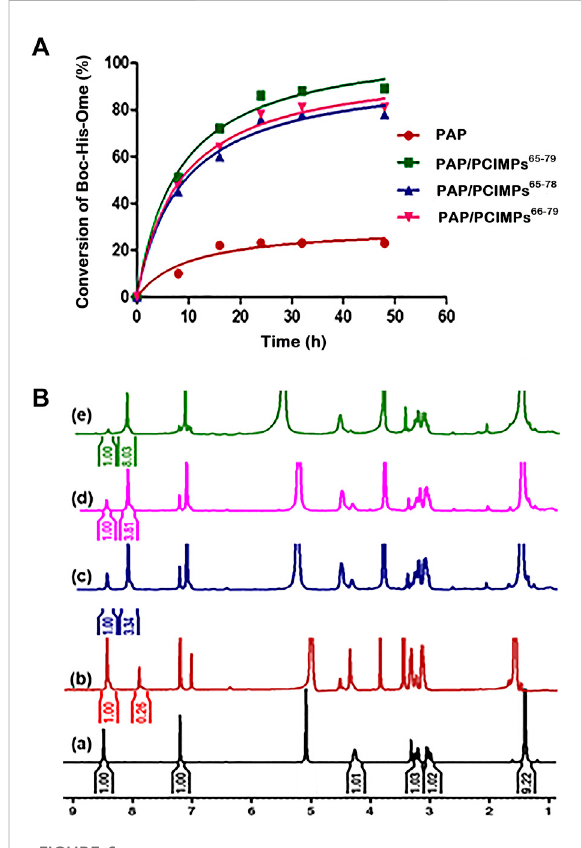
FIGURE 6 (A) Results of esteri fi cation of Boc-His-OH at 35 ° C at various intervals of reaction times. (B) 1 H-NMR spectra of (a) the starting material (Boc-His-OH), and the reaction mixture of the starting materialandesterformedby (b) PAP, (c) PAP/PCIMPs 65 – 78 , (d) PAP/PCIMPs 66 – 79 , and (e) PAP/PCIMPs 65 – 79 (no of scans used = 32, solvent = CD 3